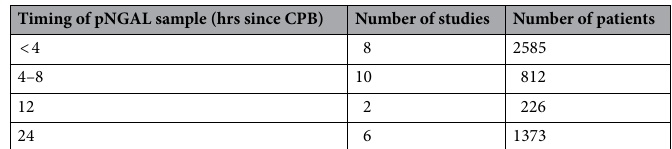
Table 2. Summary of included studies.